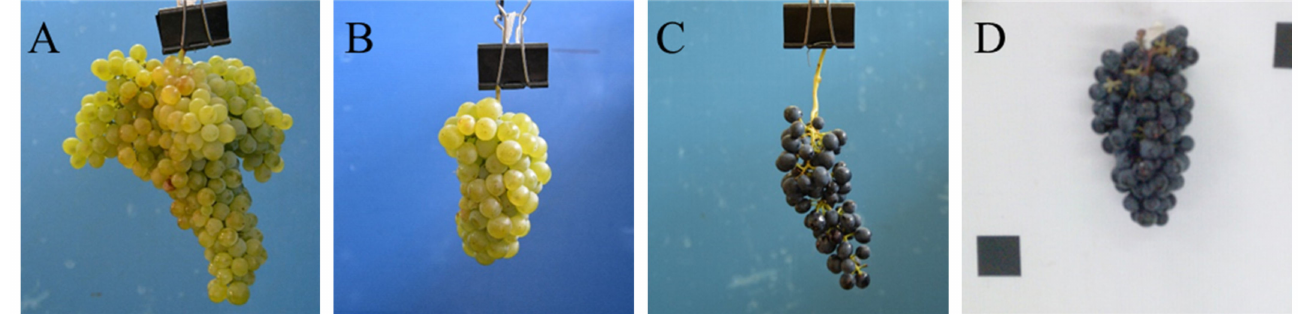
Figure 1. Bunch images collected in lab conditions from cultivars Arinto ( A ), Encruzado ( B ), and Syrah ( C ) at the PT site in 2019 and cultivar Cabernet Sauvignon ( D ) at the SA site in 2021. The SA site data were collected during the 2020–2021 season, near harvest (March 2021). A sample of 96 bunches from 16 different vines of the cultivar Cabernet